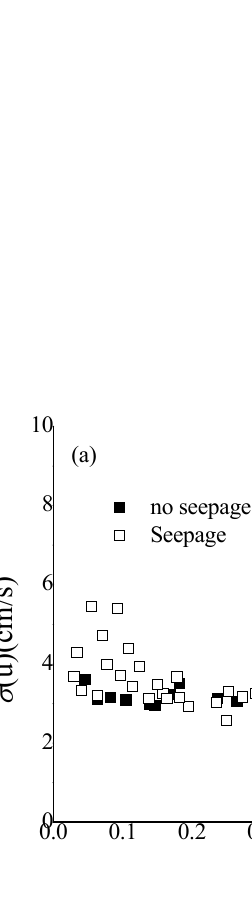
Figure 7. Profiles of ( a ) streamwise turbulence intensity and ( b ) vertical turbulence intensity for all experiments of this study.